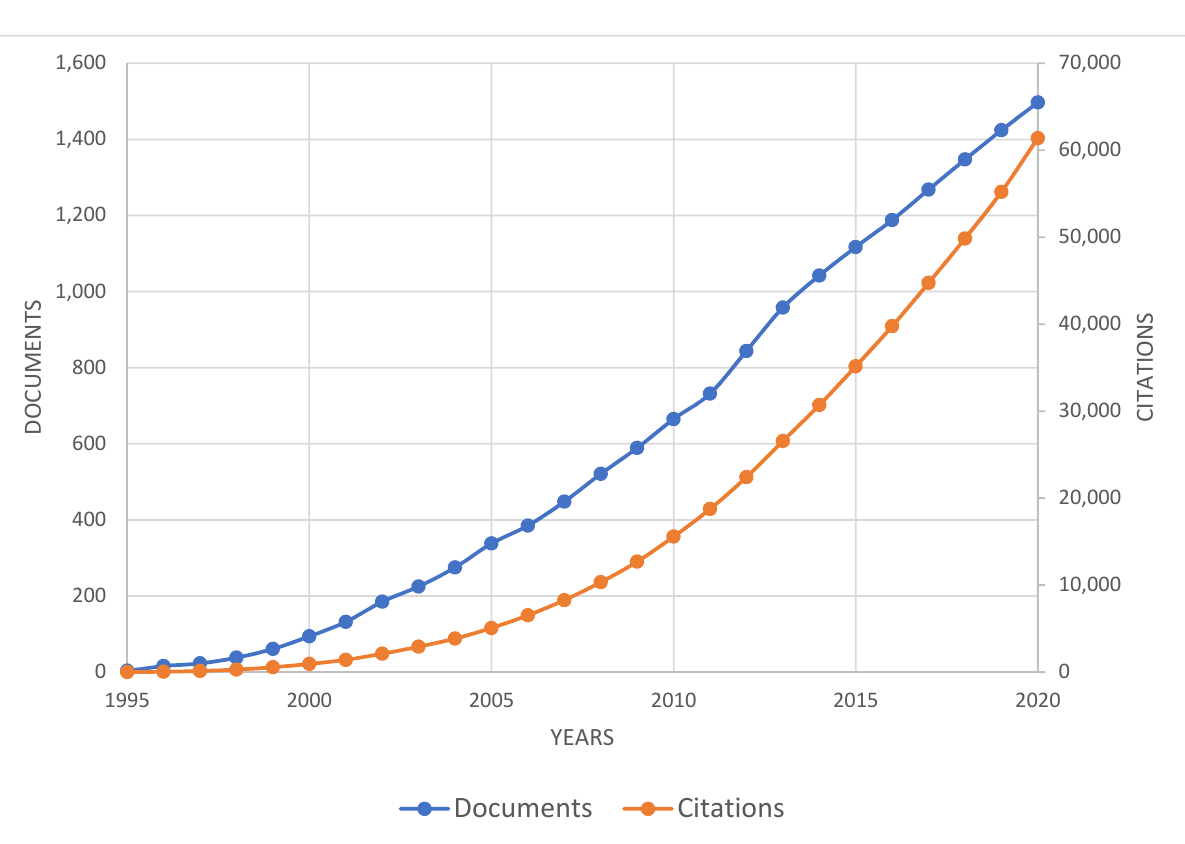
Publications and citation trends of the relationships between wine polyphenols and health research are reported in Figure 2.